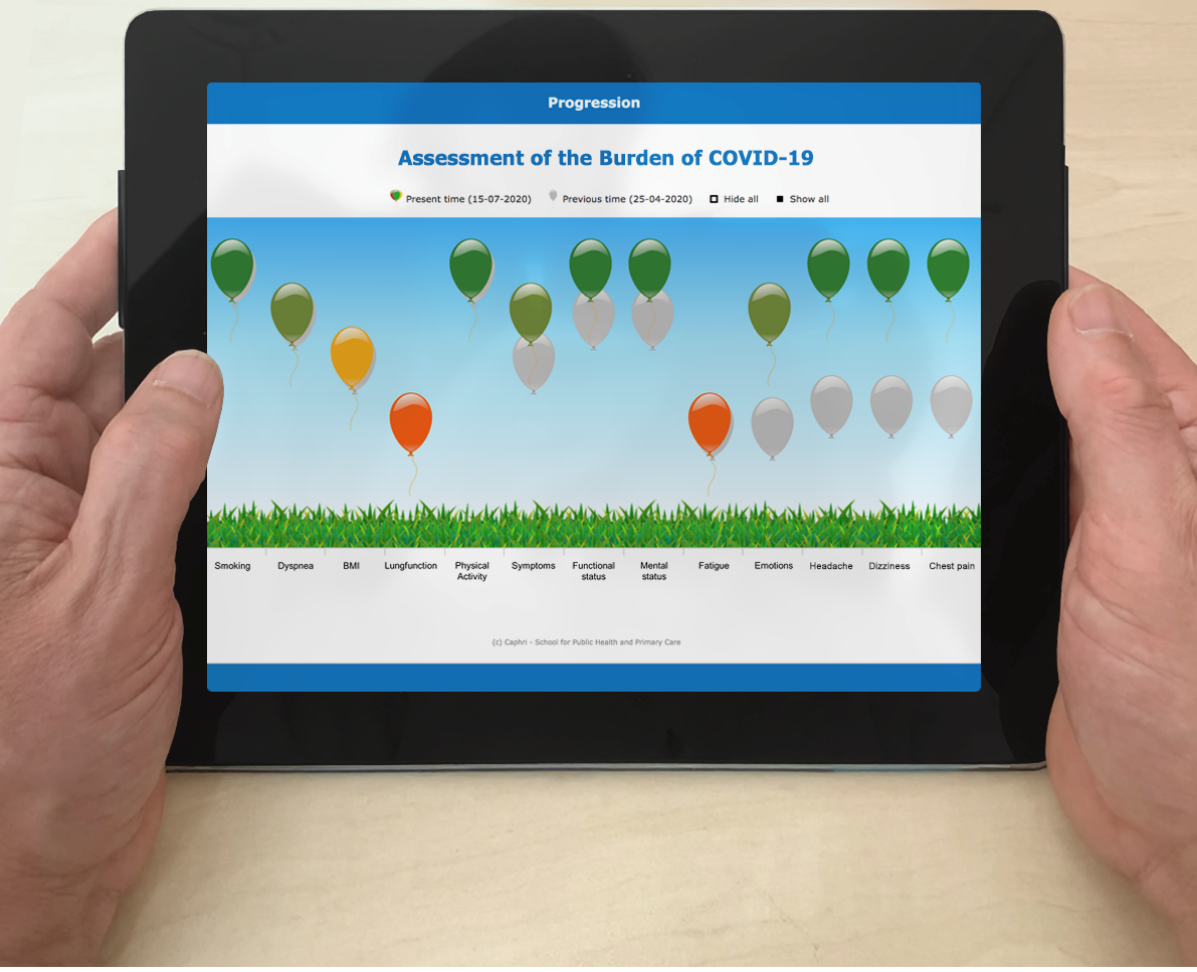
patients, diagnosed